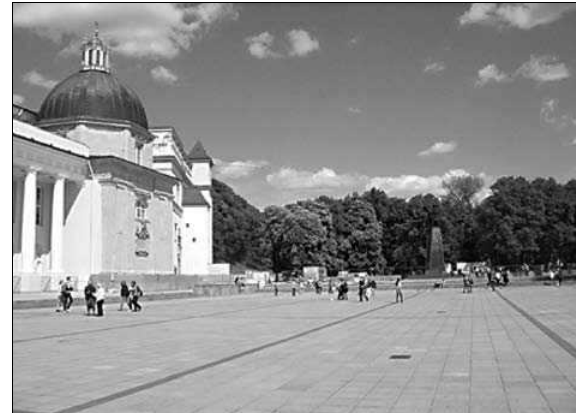
Fig. 2. Grand Duke Gediminas Monument on arkikatedra Square, Vilnius (sculpt. V. kašūba, archit. h. k. Šilgalis), 1996. View along longitudial axis of the